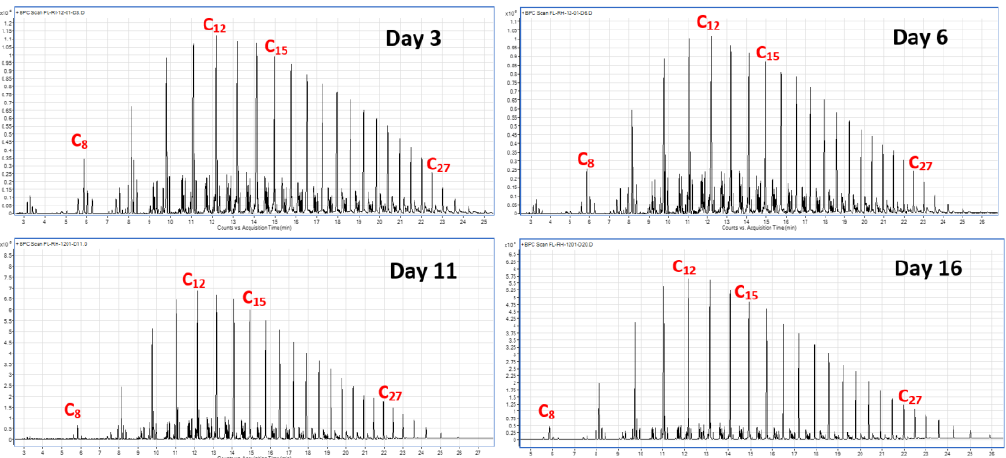
Figure A10. Chromatogram results for collected liquid products on days 3, 6, 11, and 16 in R4.